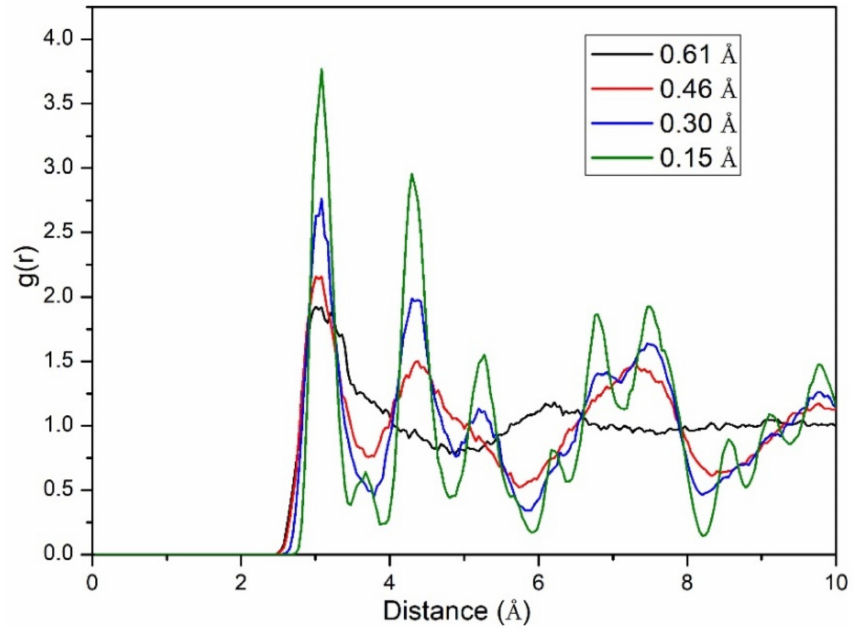
Figure 9. RDF of different distorted structures of Sb 2 Te 3 after 3ps NVE MD simulations. It is clearly shown that when the distortion is large enough, the locally distorted structure will lose its long-range order and be finally